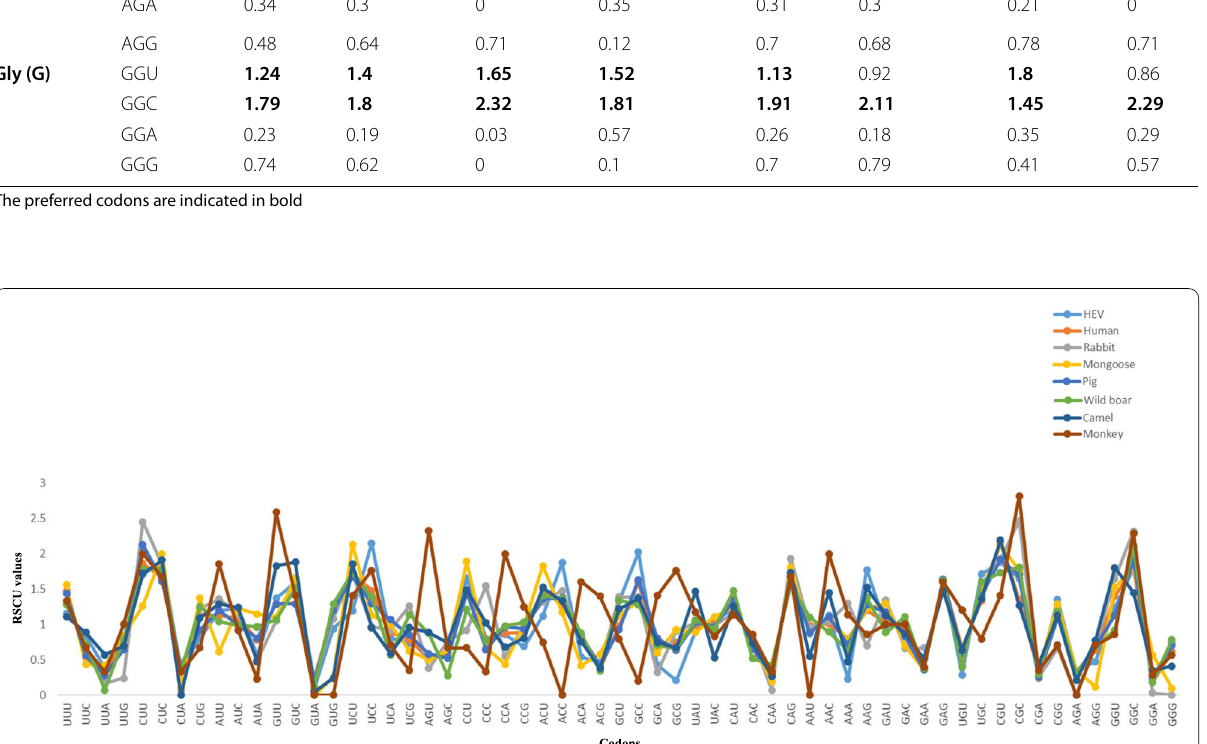
Fig. 2 Comparative analysis of relative synonymous codon usage (RSCU) patterns between HEV and its hosts (human, rabbit, mongoose, pig, wild boar, camel, and